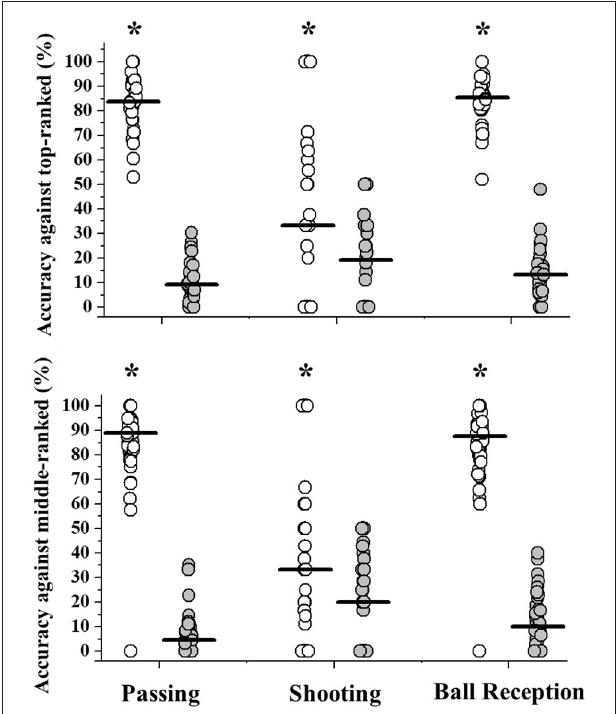
FIGURE 4 | Accuracy (%) values observed according to opponent quality (top or middle-ranked) when using the dominant (open symbols) or non-dominant limb (gray symbols). Horizontal lines represents the group median values. *Significant differences between limbs observed through Wilcoxon’s test ( p <